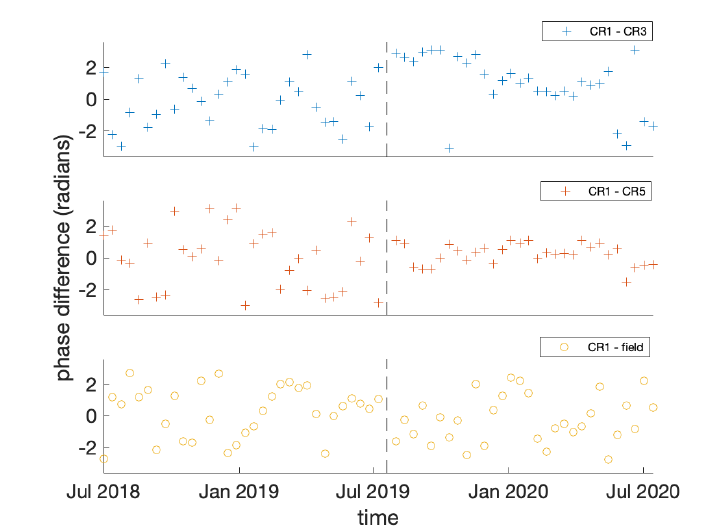
Figure 7. Stabilisation of phase differences after the installation of the corner reflectors. The vertical line shows the time of installation. The top and middle graphs show phase differences between two corner reflectors, and the bottom panel is the phase difference between the location of a corner reflector and a random point on the field.